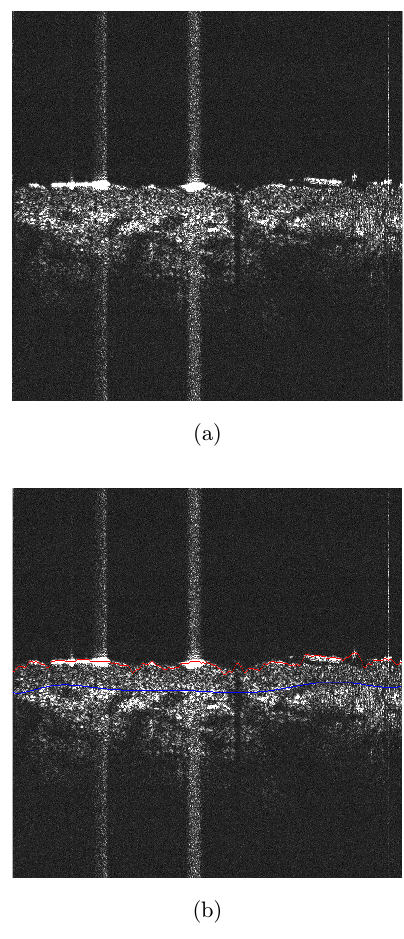
Fig. 6. (a) OCT image with saturation and shadowing arti- facts. (b) ET measurement. Red line: air-skin surface. Blue line: dermal-epidermal junction (c) low-contrast OCT image. (d) Only skin surface can be detected.